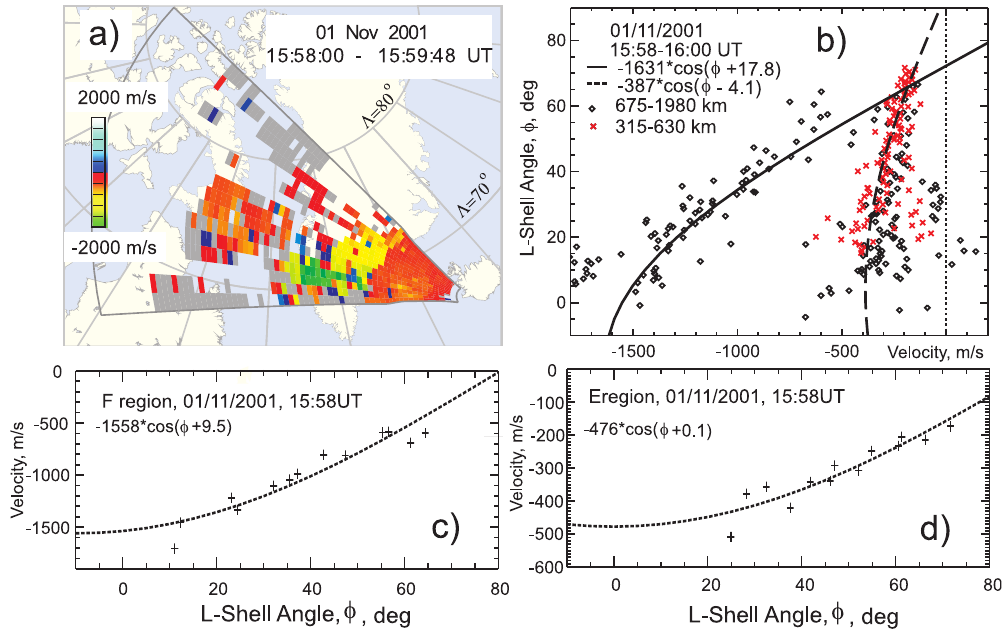
Fig. 8. (a) Stokkseyri HF radar velocity map obtained on 1 November 2001 at 15:58:00–15:59:48UT. The magnetic parallels of 70 ◦ and 80 ◦ are shown by grey line to simplify estimates of the L-shell angle φ . (b) Scatter plot of the velocity versus L-shell angle for the map shown in panel (a) and cosine fit results for the fit to Stokkseyri velocities for 1 November 2001 at 15:58–16:00UT. (c) Cosine fit results for the fit to the peak line-of-sight F-region velocity estimates for 1 November 2001 at 15:58–16:00UT. (d) Cosine fit results for the fit to the peak line-of-sight E-region velocity estimates for 1 November 2001 at